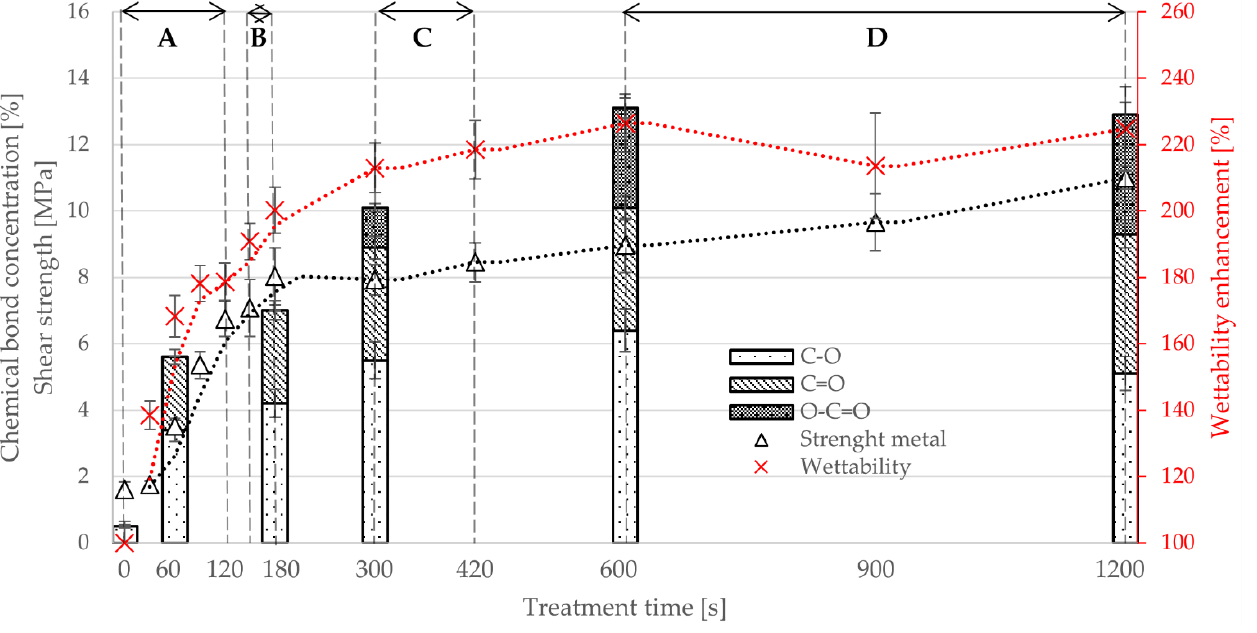
Figure 10. Correlation between concentration of O=C–O, C=O, C–O groups, shear strength (metal substrate), wettability enhancement and treatment time (disproportional timeline, minor unit 30 s).